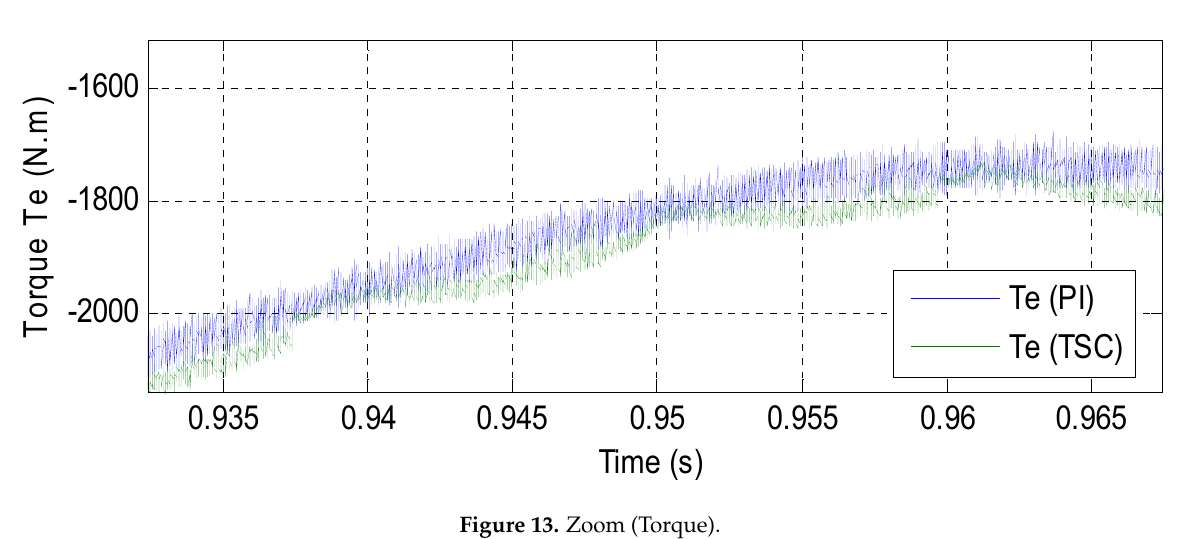
Figure 12. Zoom (Active power). Figure 12. Zoom ( Active power). Figure 12. Zoom ( Active power).